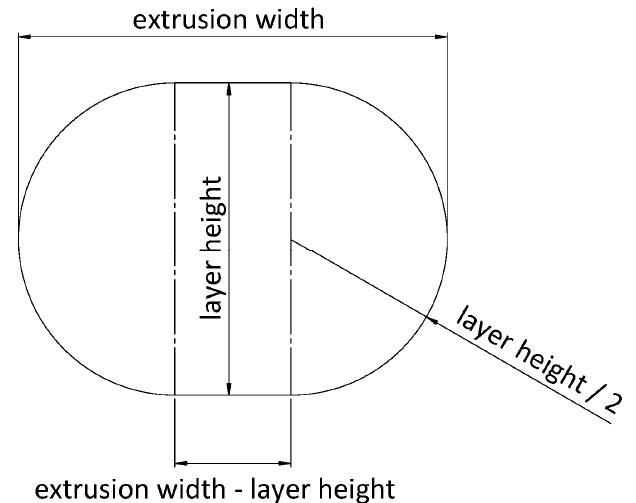
Figure 2. Filament profile shape and dimension.